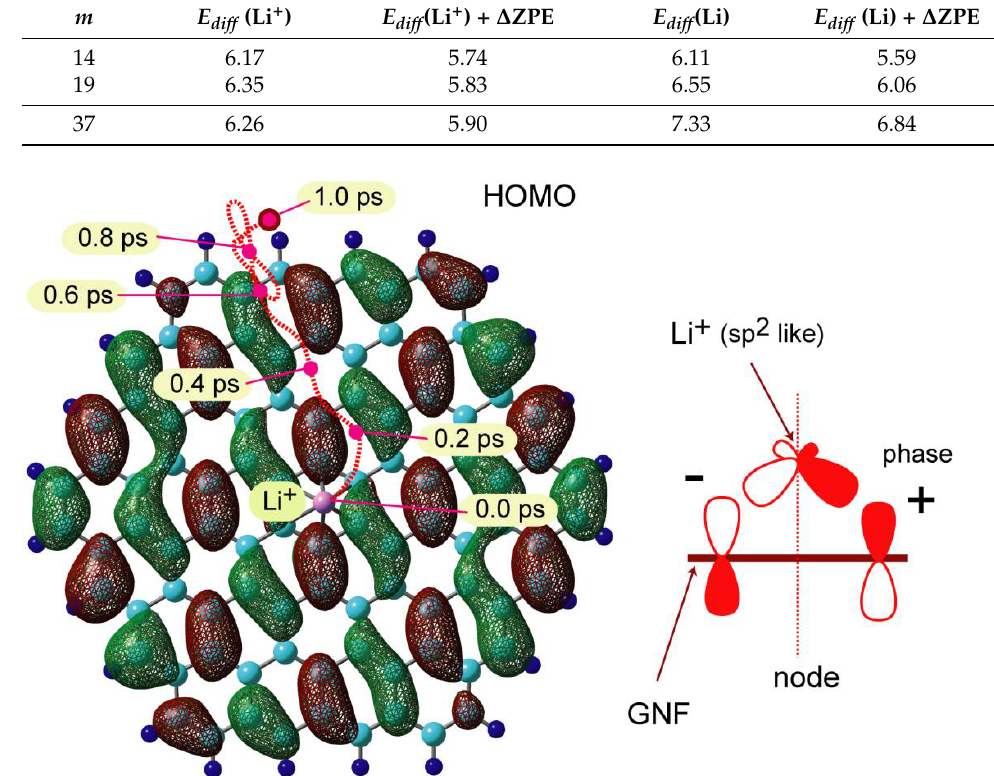
Figure 9. ( Left ) Sample trajectory of Li + on GNF at 300 K (dotted red curve), spatial distribution of HOMO of GNF–Li + , and the phases of HOMO (green and brown colors). ( Right ) A schematic illustration of the interaction of molecular orbitals between Li + and GNF during the diffusion. The trajectory calculation was carried out using the direct ab initio molecular dynamics (MD) method. The Li + ion diffuses along the node of HOMO of the GNF–Li + system. Reprinted with permission from [42]. Copyright 2006 American Chemical Society.